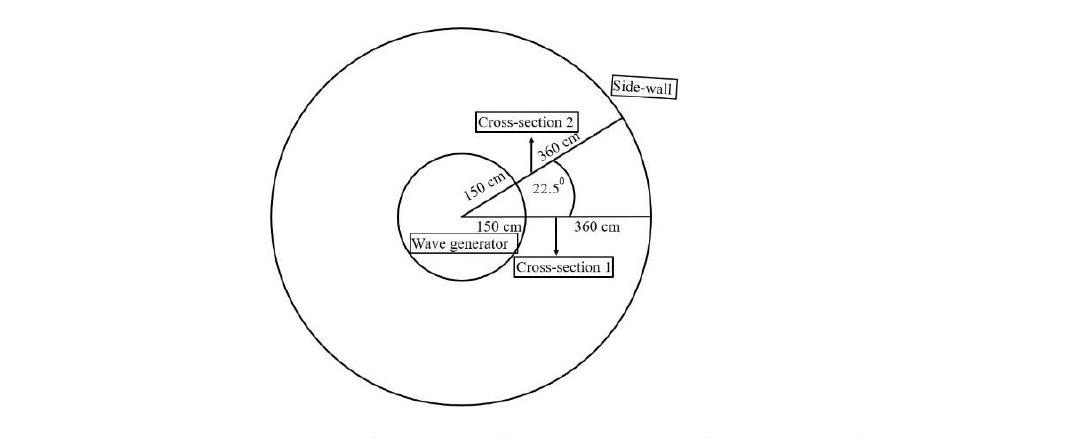
Figure 3. Plain view with two-cross-sectional measurement locations. Table 1. Experimental conditions.